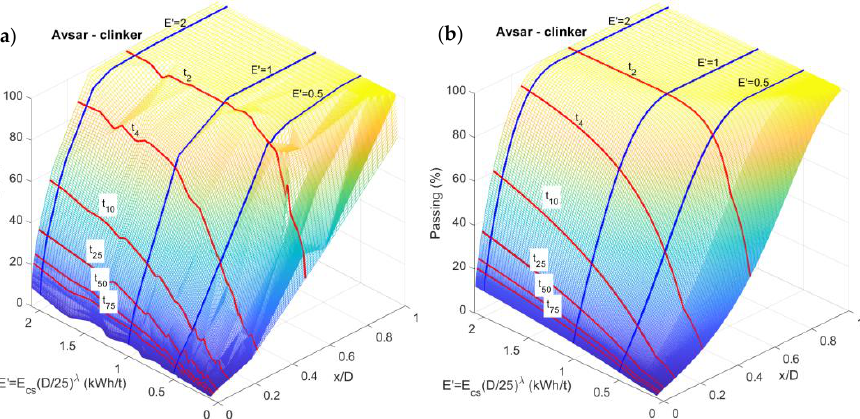
Figure A12. 3D breakage plots for Avsar’s [ 23] clinker. ( a ) from data. ( b ) from double fan model (direct fit, variable 𝜆 ).